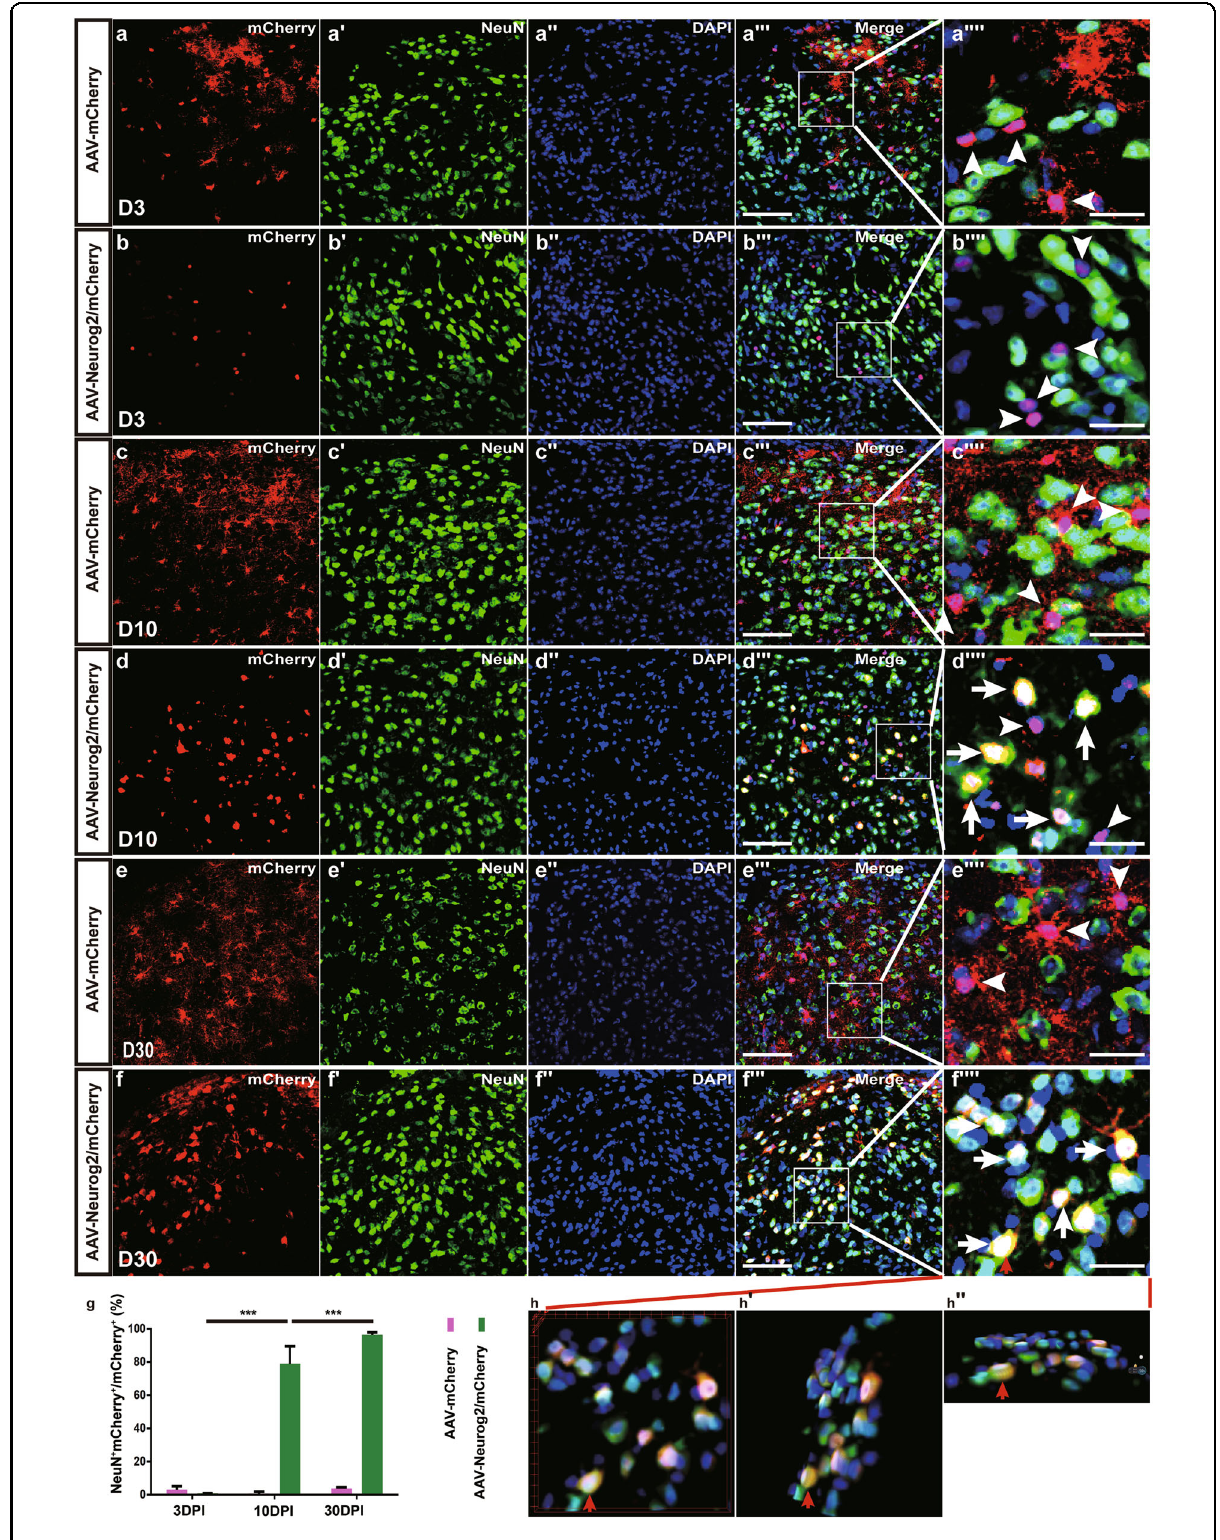
Fig. 1 (See legend on next